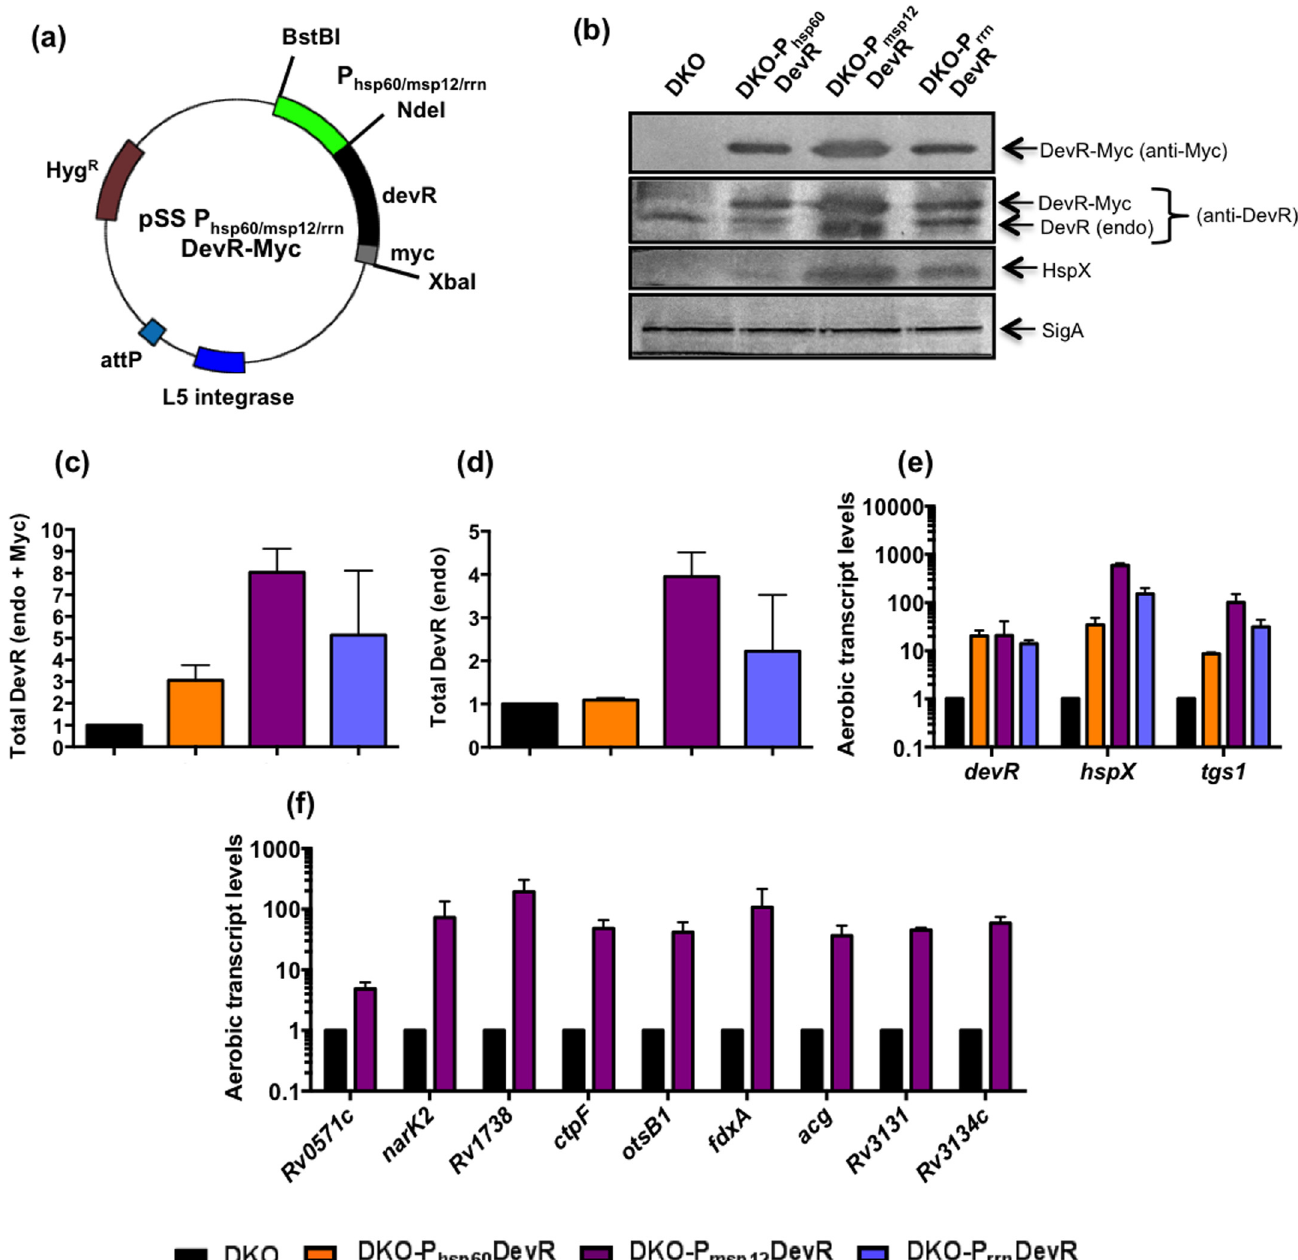
Fig 1. Overexpression of DevR in Mtb DKO. (a) Vector map of integrating plasmid overexpressing DevR. (b) Western blotting of lysates from aerobic Mtb cultures. A representative blot is shown. (c) Total DevR levels (DevR + DevR-Myc) in DKO-complemented strains. (d) DevR (endo) level in DKO-complemented strains. (e) RT-qPCR analysis of select DevR regulon genes in DKO-complemented strains. (f) RT-qPCR analysis of additional DevR regulon genes in DKO-P msp12 DevR. Data is Mean ± SD of 2 biological replicates. SigA was used as a loading control in (b). In panels (c) to (f), protein and transcript levels are shown relative to that in DKO (considered as